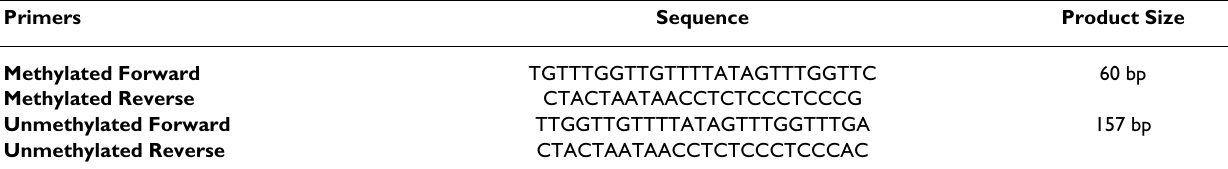
Table 3: Primer sequences used for methylation specific PCR Primers